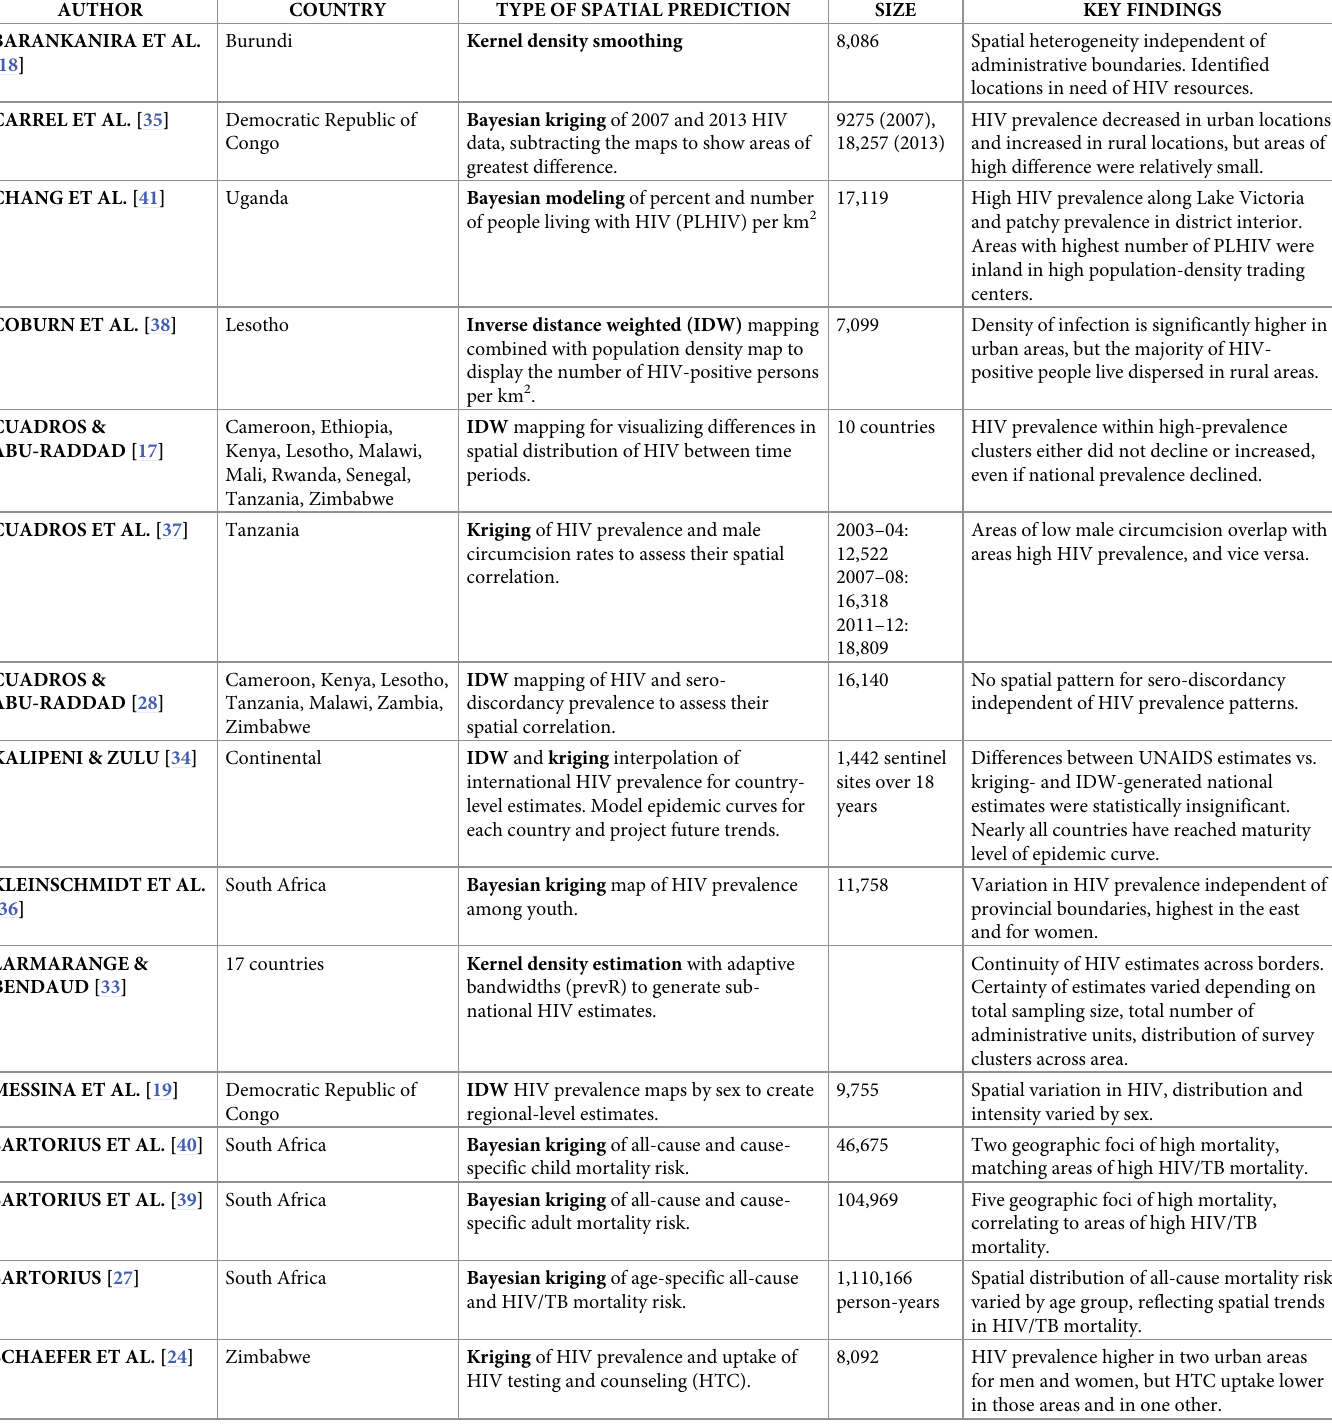
Table 2. Studies creating continuous surface maps of